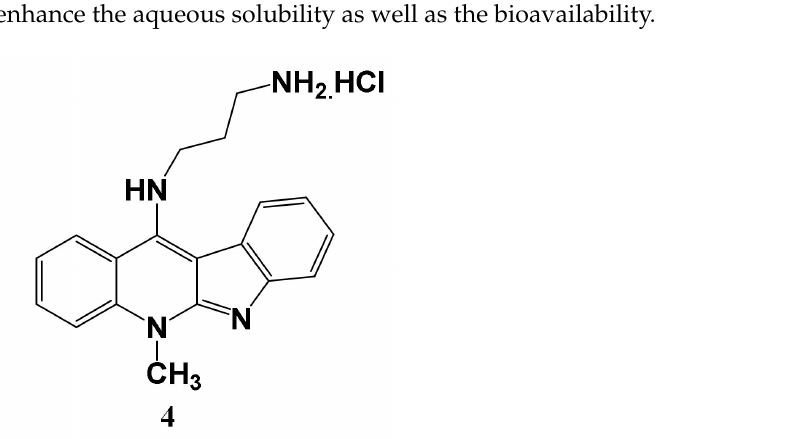
Figure 2. Structure of 11-Aminopropylamino neocryptolepine hydrochloride salt